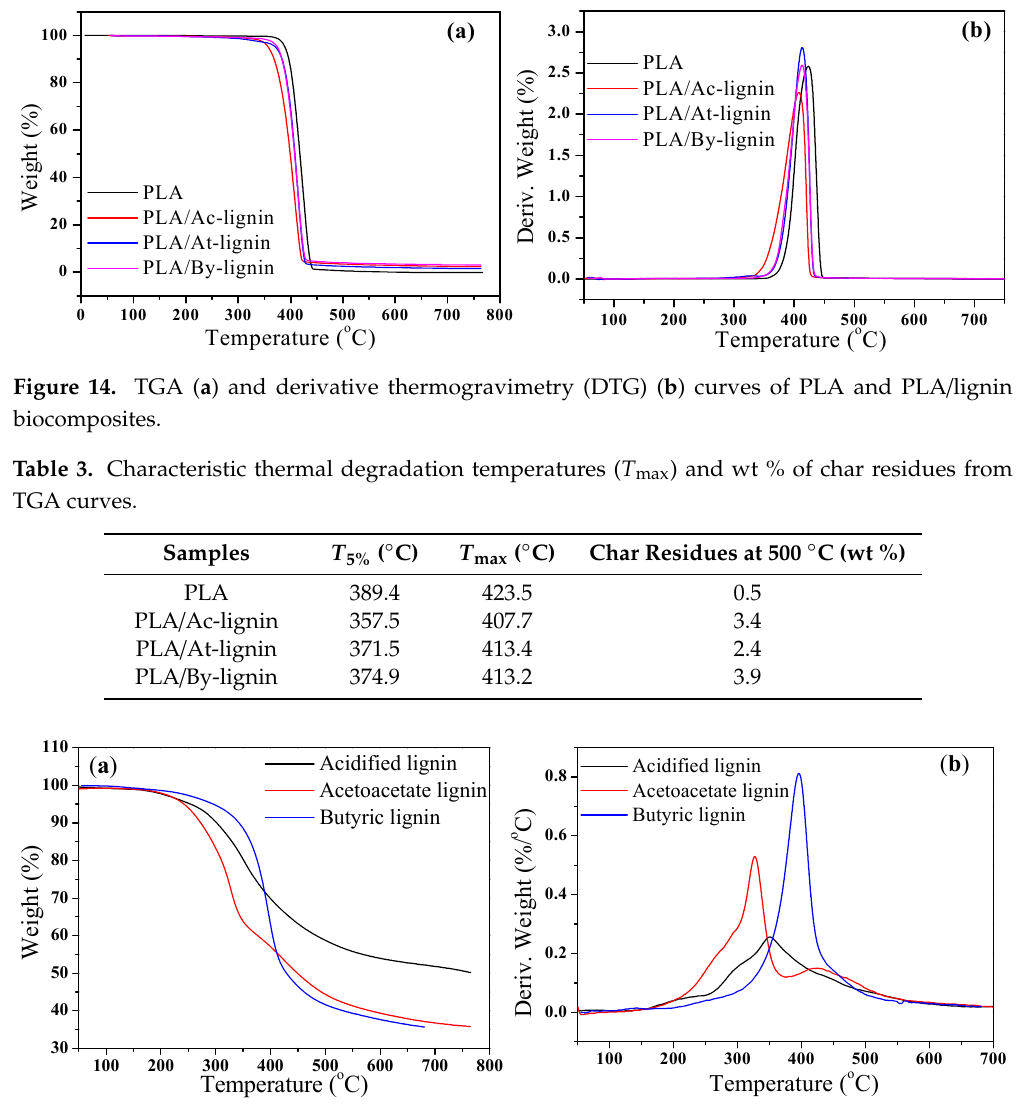
Figure 15. TGA ( a ) and DTG ( b ) curves of acidified, acetoacetate, and butyric lignin. Table 3. Characteristic thermal degradation temperatures ( T max ) and wt % of char residues from TGA curves.